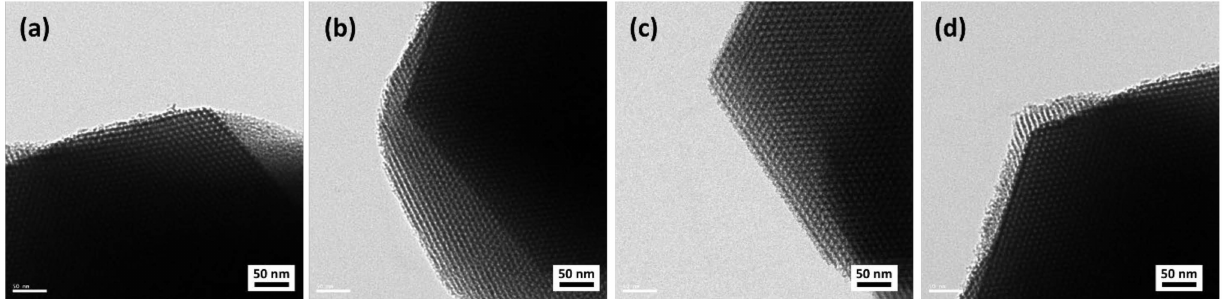
Figure 5. TEM images of the MS samples synthesized from MSWI ash slag at various NaOH concentrations: ( a ) MS-1M, ( b ) MS-2M, ( c ) MS-3M and ( d )